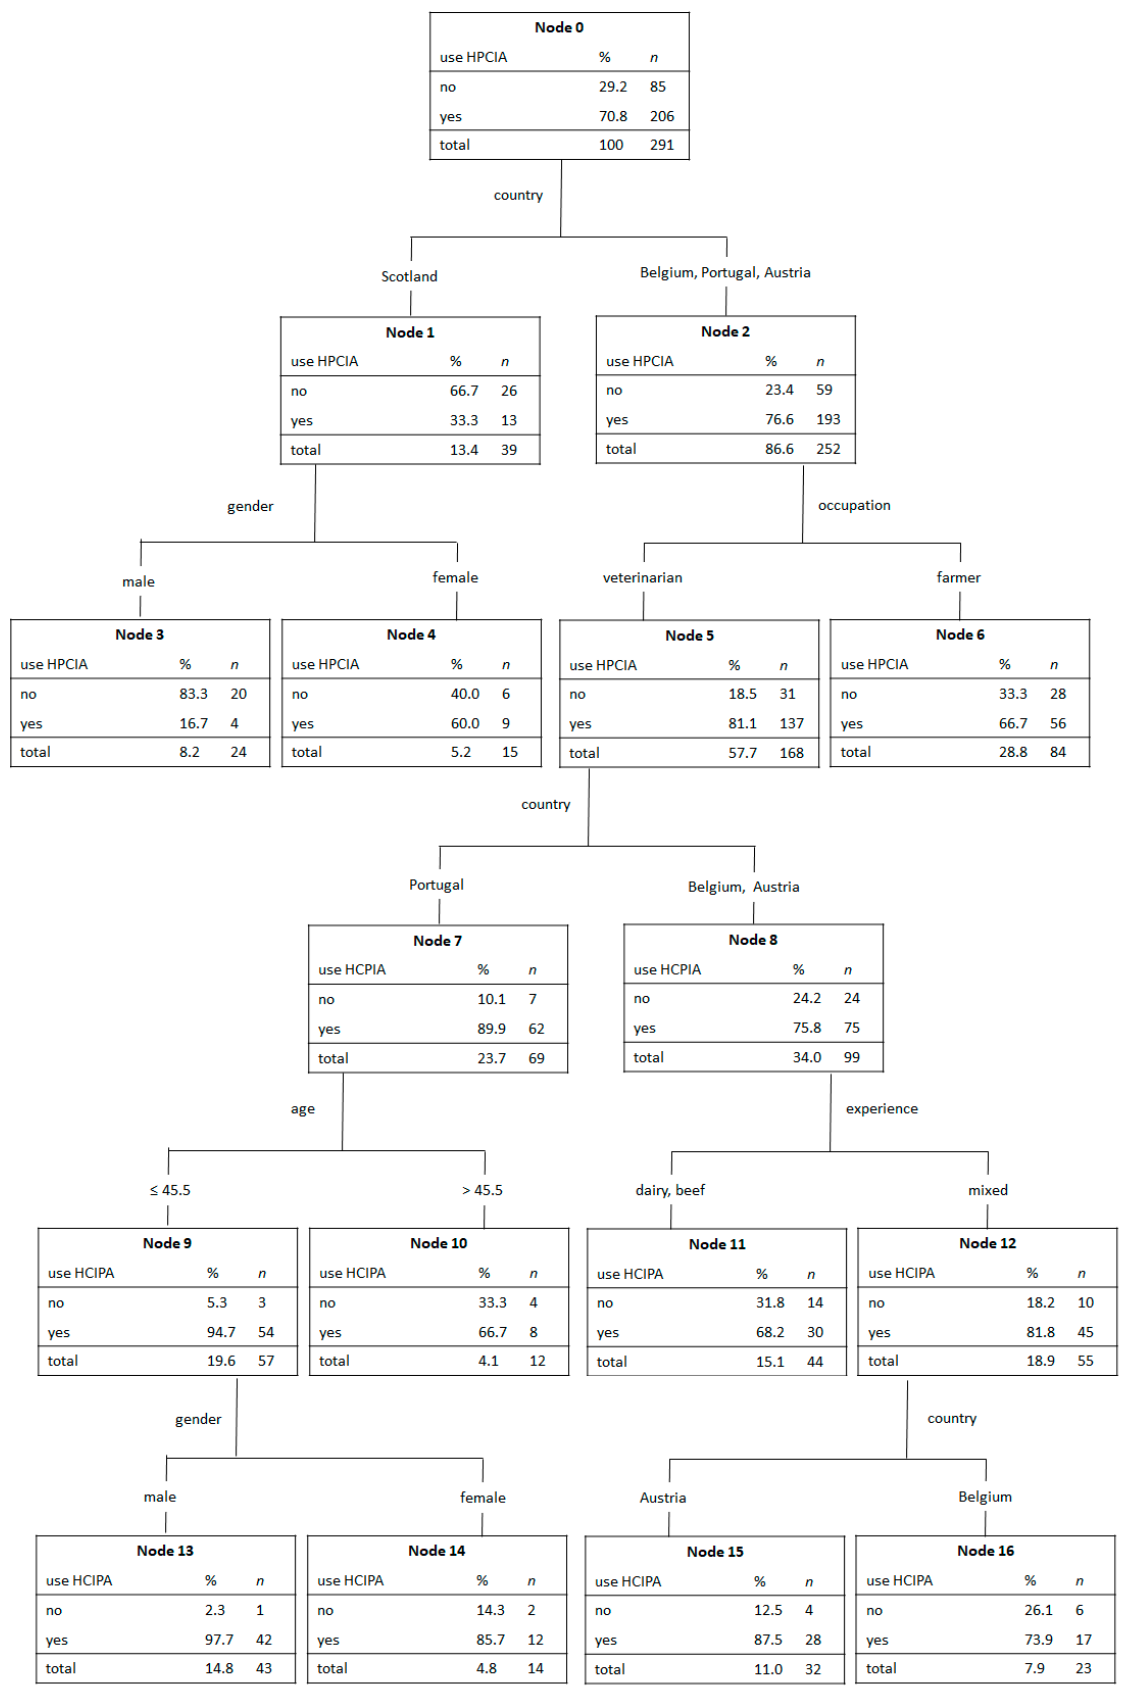
Figure 4. CART: Association of different factors on the use of HPCIA for the treatment of NCD.